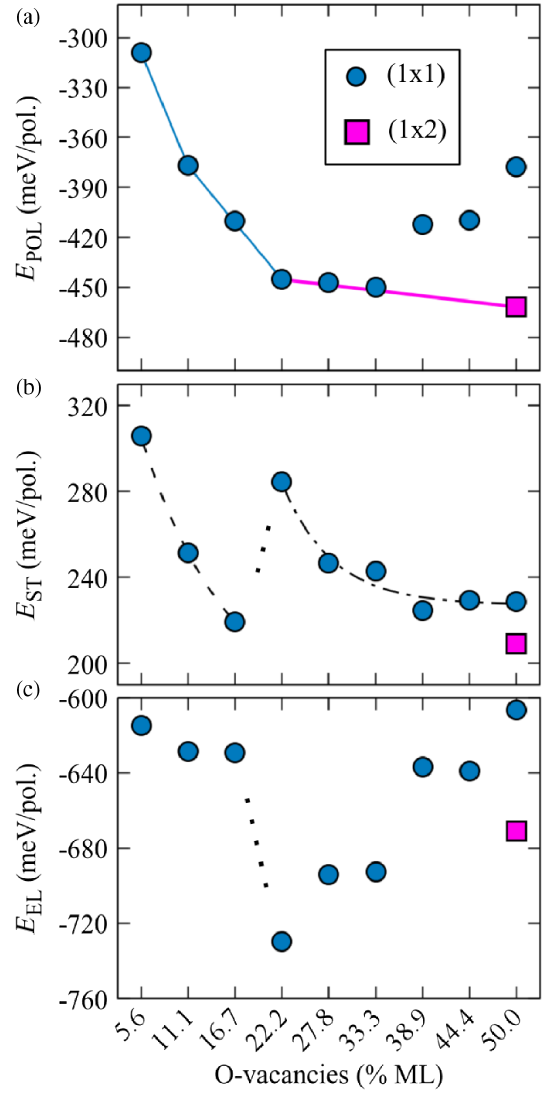
5. Polaron energies (meV/polaron) as a function of c V (a) Polaron formation energy E , computed as the difference POL between the ground states of the localized and delocalized solutions. (b) Strain energy E , i.e., energy cost to locally ST distort the lattice in order to accommodate polarons. (c) Electronic energy E , i.e., energy gained by localizing the electron in the EL distorted